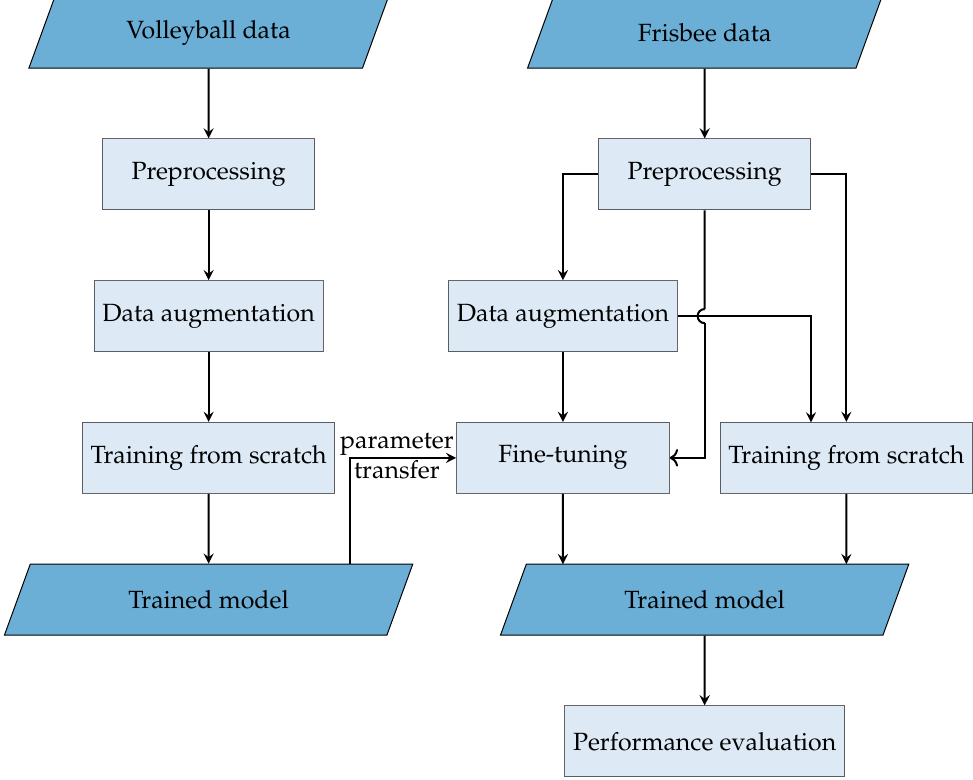
Figure 1. A visual summary of the workflow of our paper. We developed the first human activity recognition system for Ultimate Frisbee. Therefore, we use a convolutional neural network. Addi- tionally, we investigated the possible improvement of the classification using a network pre-trained on volleyball